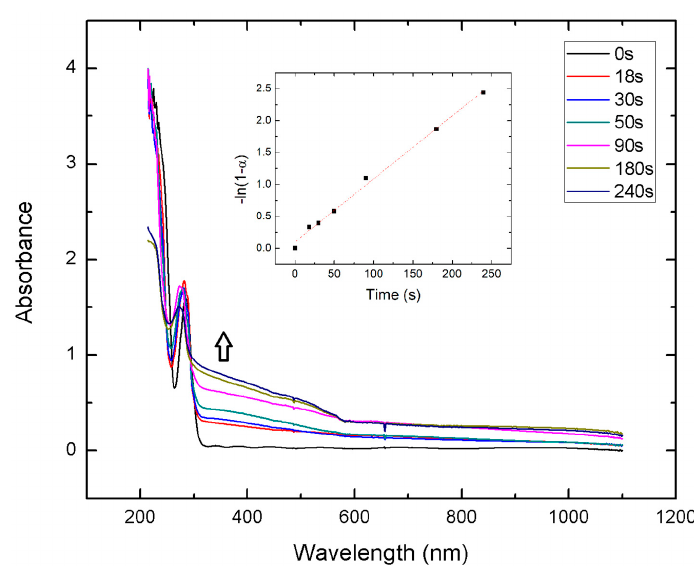
Figure 8. UV-visible absorbance of m -aminophenol films on a high-density polyethylene substrate treated with DBD. The arrow shows the direction of intensity changes of the peak at 319 nm during the plasma treatment.